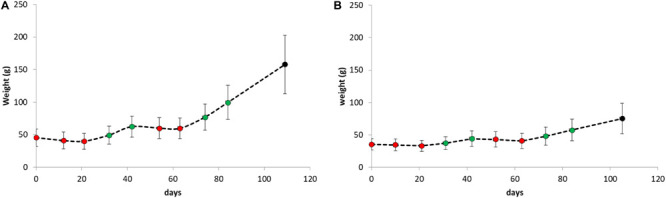
Body weight as weekly determined during the period of the replicate starvation and refeeding experiments of (A) Atlantic salmon and (B) Gilthead seabream. The red dots represent measurements during starvation periods and the green dots during refeeding periods.